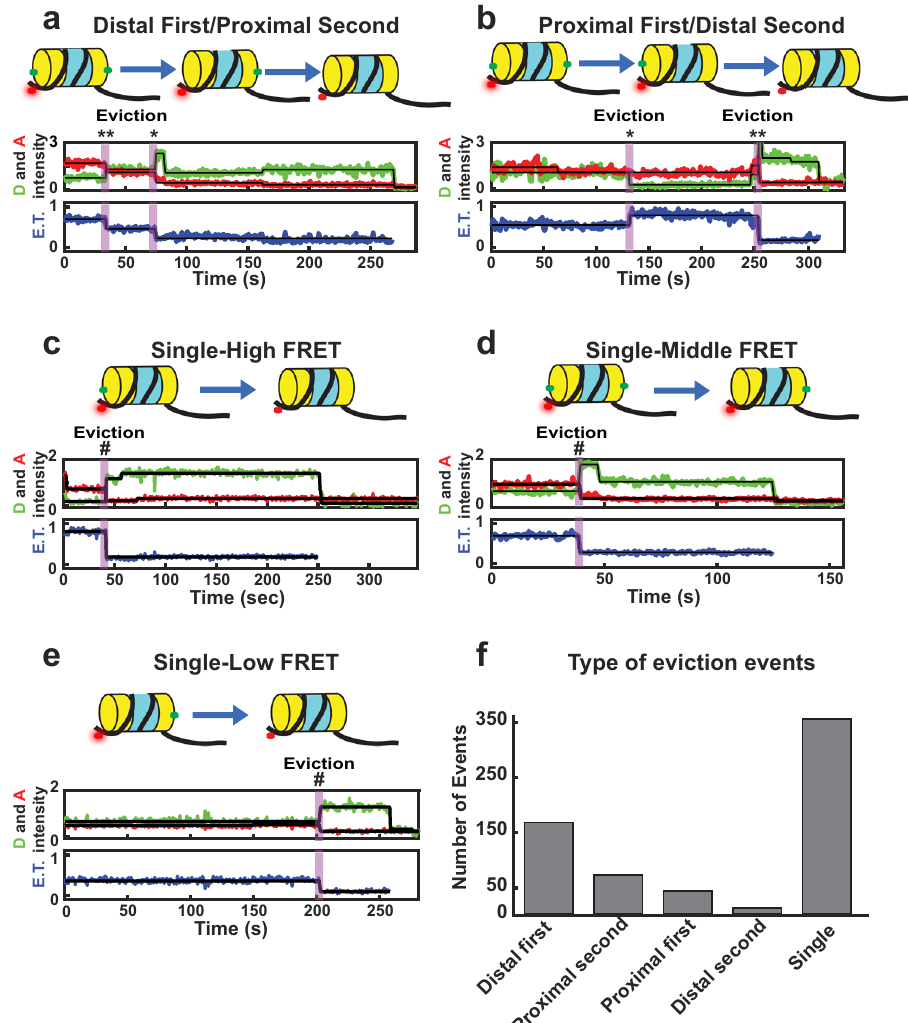
Fig. 2 | SWR1C evicts distal and proximal H2A from the nucleosome. a – e Example trajectories. The Cy3B donor fl uorophore was excited, and donor emission (green) and ATTO 647N acceptor emission (red) were recorded (top panel) and used to calculate energy transfer ef fi ciency (blue, bottom panel). a Example trajectory of SWR1C evicting distal H2A (**) from the nucleosome fol- lowed by the eviction of proximal H2A (*). b Example trajectory of SWR1C evicting proximal H2A (*) from the nucleosome followed by the eviction of distal H2A (**).